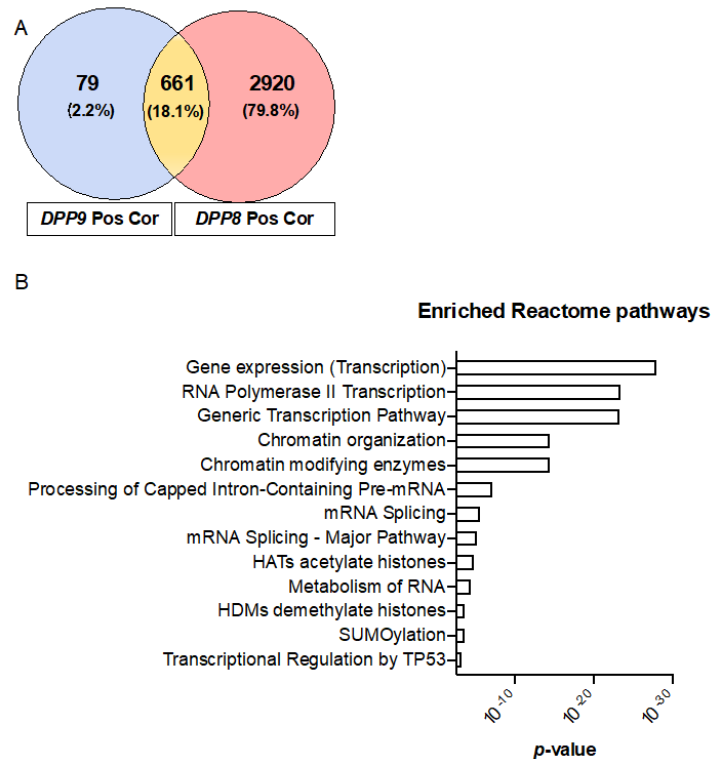
Figure 5. Enriched reactome pathways of genes that were positively correlated with DPP9 and DPP8 . ( A ) Venn diagram of the genes that were positively correlated with DPP9 and DPP8 , with Pearson correlation coefficient greater or equal 0.5. “Pos Cor” refers to positive correlation. ( B ) Enriched reactome pathways associated with positively correlated genes in-common between DPP9 and DPP8